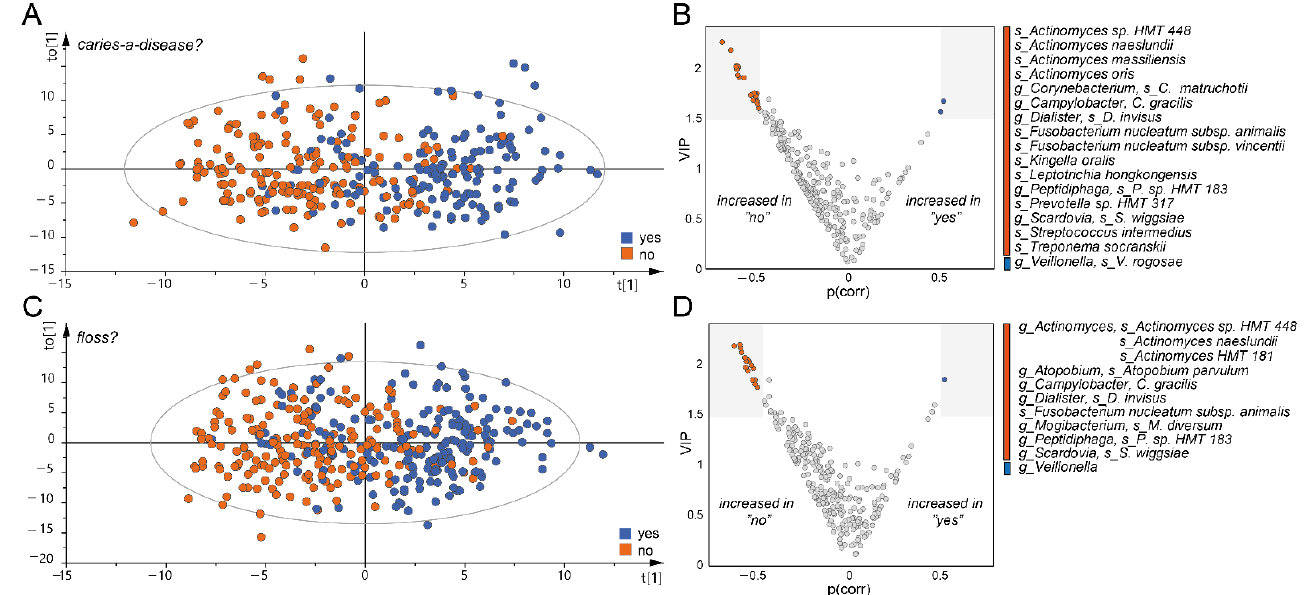
Figure 2. Identification of genera and species which are most strongly associated with two oral health behaviours. Orthogonal partial least square regression discrimination analysis was used to evaluate the association between participants answer to the questions ( A , B ) “ do you think caries is a disease? ” and ( C , D ) “ do you use floss or a toothpick?” and the oral microbiota composition. The model score plots ( A , C ) illustrate the observed group separation (each participant is represented by a dot) based on their microbiota profile. ( B , D ) In order to identify the subset of bacterial species/genus important for the observed group separation, selection based on a combination of Variable Influence in Projection (VIP) and p (PLS correlation coefficient) was performed. VIP is a metric that summarizes the importance of each variable in driving the observed group separation and p (corr) is a loading scaled as a correlation coe ffi cient (ranging from − 1.0 to 1.0) between the model and original data. Inclusion criteria were set to VIP >1.6 and p (corr) < − 0.5 or >0.5. (g_) indicates genus level, (s_) species level.